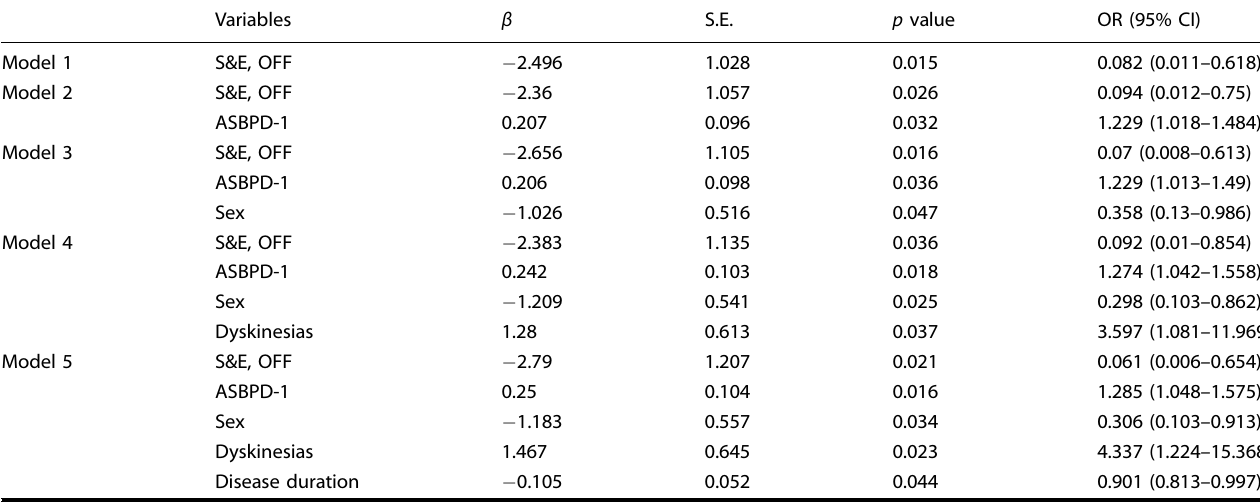
Table 6. Stepwise logistic regression analysis for variables predicting treatment